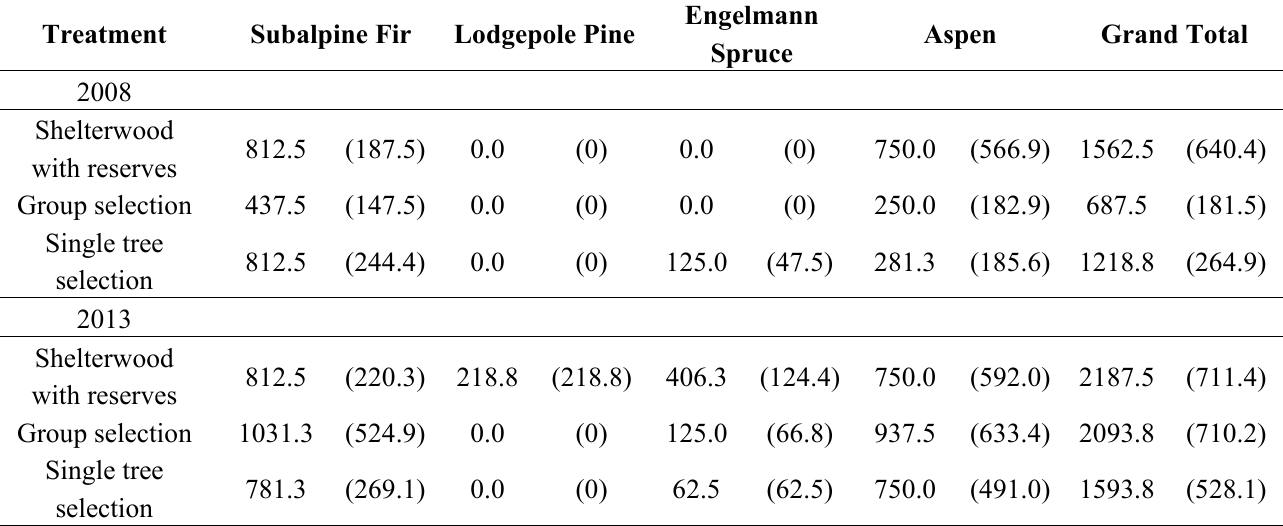
Table 4. Regeneration density (trees per hectare) by treatment for 2008 and 2013 for the T.W. Daniel Experimental Forest. The associated standard errors are in parenthesis.